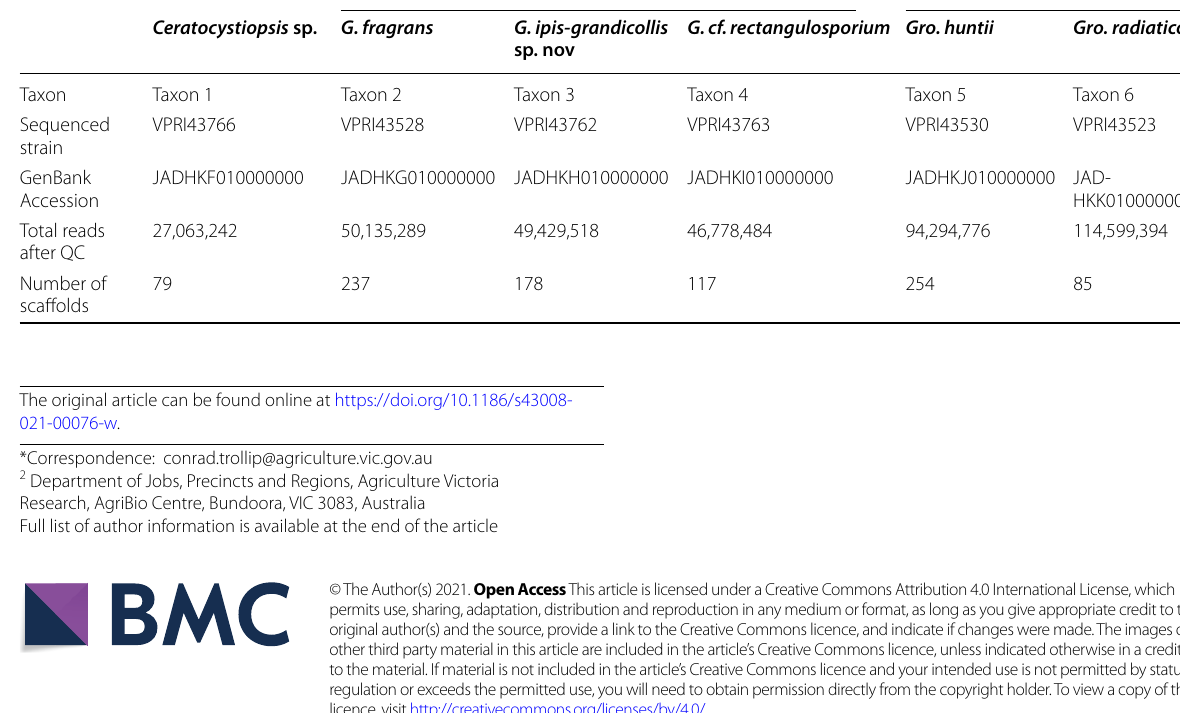
Table 3 Genome summary statistics of representative ophiostomatoid isolates sequenced in this study